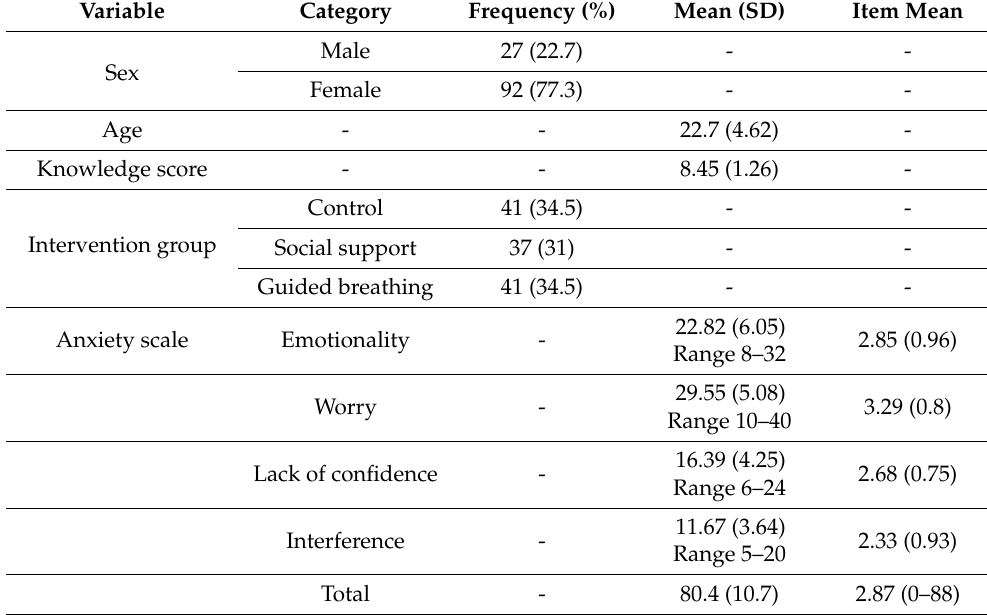
Table 1. Characteristics of the participants.